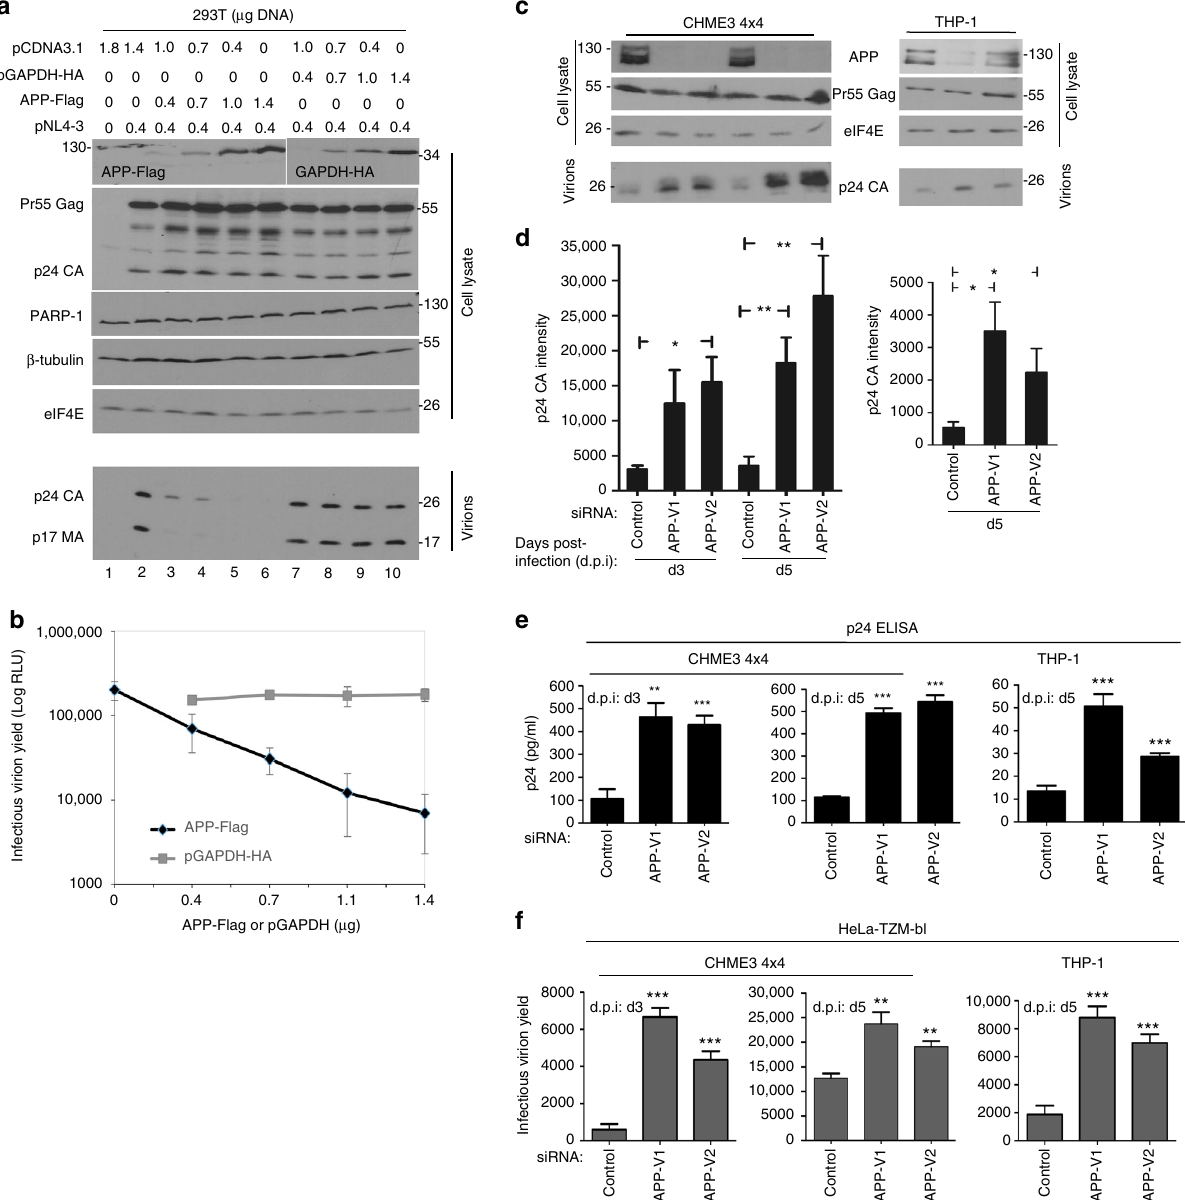
Fig. 3 APP inhibits production of HIV-1 particles. a Increasing expression of human APP 770 (APP-Flag) reduces the levels of MA/CA-containing HIV-1 particles in culture supernatants compared with human GAPDH (GAPDH-HA) controls. b Infectious virion yields from APP or GAPDH expressing 293T cells measured using TZM-bl indicator cells. c RNAi-mediated depletion of APP relieves an endogenous block to production of extracellular virus particles in CHME3 4 × 4 cells and differentiated THP-1 cells infected with pNL4-3-derived HIV-1 at 3 and/or 5 days post-infection (d.p.i: d3 and d5). d Quanti fi cation of p24 CA intensity in supernatants from c . e Measurements of p24 CA levels in supernatants from c by ELISA. f Infectious virus yield in samples from c was measured using TZM-bl indicator cells. The data in b , d , e , f represent average of 3 replicates, and are represented as mean +/ − SEM (one-way ANOVA; * P < 0.05, ** P < 0.01, *** P < 0.001). Molecular weight markers (in kDa) are shown either to the right or to the left of